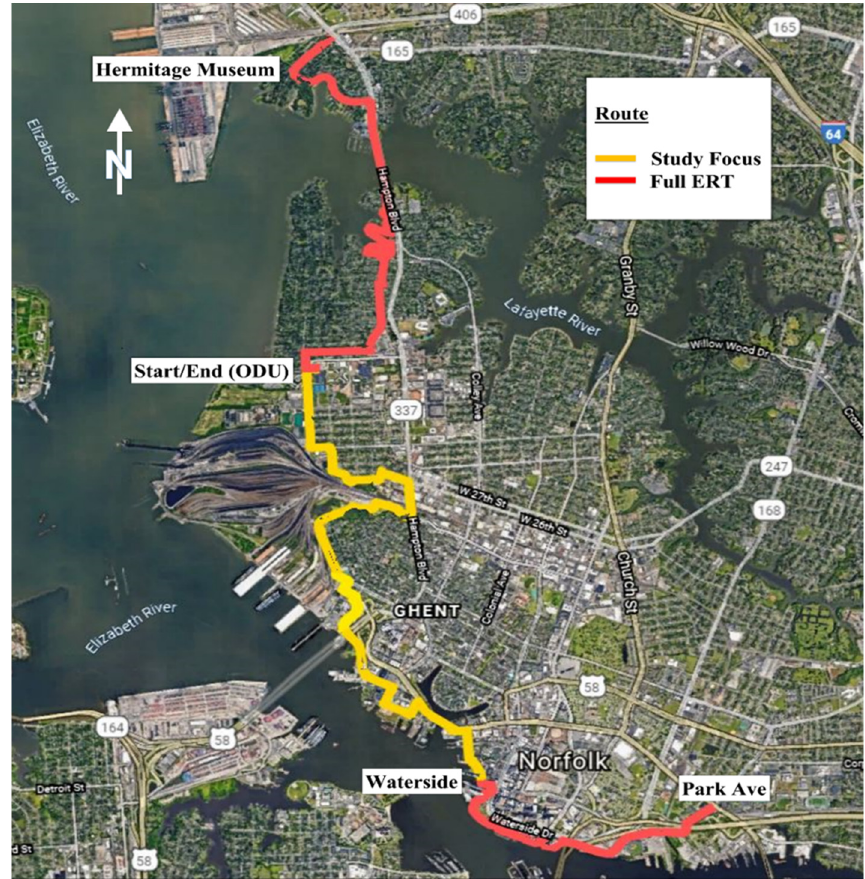
Figure 1. Map of the Elizabeth River Trail with data collection section. Note: Original graphic created using Google Maps.